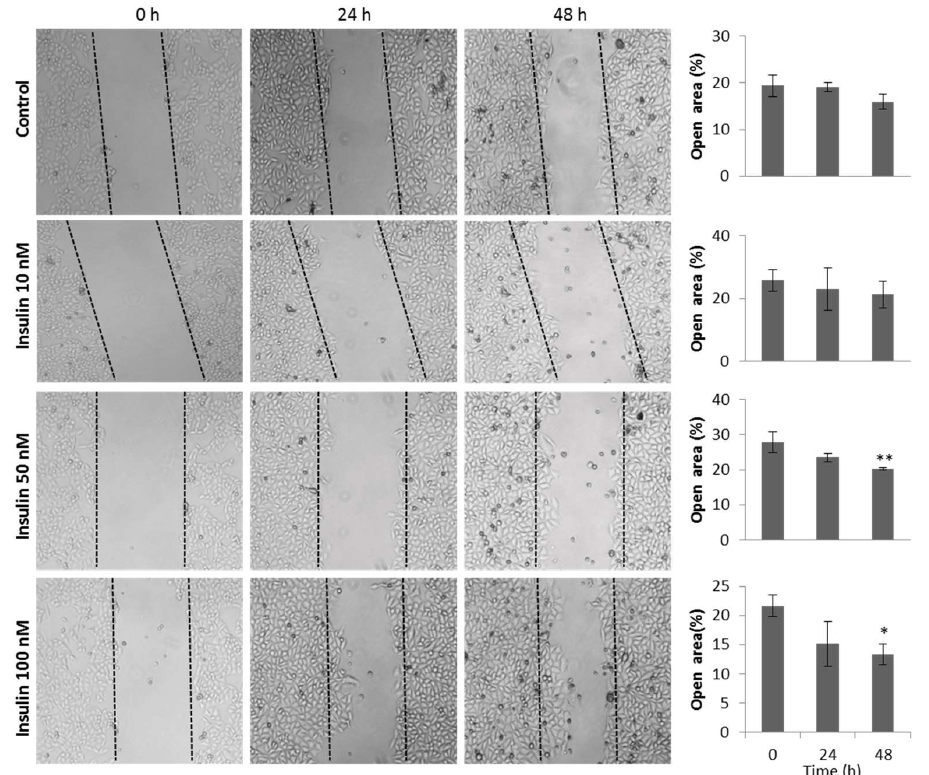
Figure 5. Insulin treatment increases migration of HeLa cells. HeLa cells were stimulated with dif- ferent concentrations of insulin in the presence of mitomycin C and with DMEM medium without SFB; cells were treated with mitomycin C in the control group. Cell migration was evaluated by quantifying the reduction in the open area (a lower percentage of the open area means a higher percentage of cell migration). The histograms represent the mean value ± standard error of the mean (SEM) of the percentage of the open area of three independent experiments in triplicate. One-way ANOVA was performed, followed by the Tukey post hoc test to compare the treated groups against the control group. * p < 0.05; ** p <